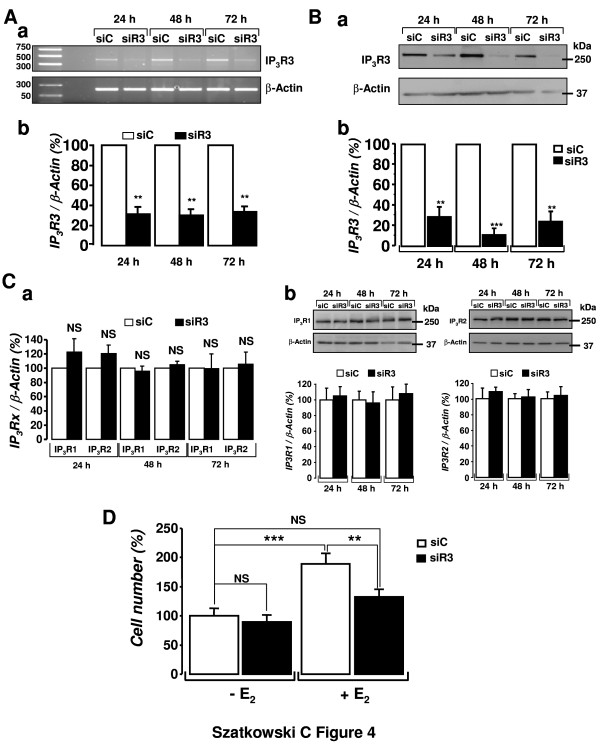
Silencing of IP3R3 by RNA interference limits the proliferative effect of E2. (A) Validation of the efficiency of the siRNAs used at the mRNA level (a, representative illustrations for 3 independent experiments). The IP3R3 mRNA level was lowered by about 70% (see text for details) at 24, 48 and 72 h post-transfection. (B) siR3 was responsible for a rapid and long-lasting diminution of the expression of IP3R3 at the protein level (a). Compared to control conditions, siR3 diminished the expression of IP3R3 at 24, 48 and 72 h (b). (C) Following IP3R3 silencing, the levels of IP3R1 and IP3R2 mRNA (a) and protein (b) were not significantly changed at 24, 48 and 72 h post-transfection. Representative blots for 3 to 4 independent western blotting experiments are shown. (D) MCF-7 cells were transfected with siC or siR3 and seeded for 18 h in 5-FCS and then starved for 6 h in 0-FCS. Cells were subsequently cultured in 0-FCS in the absence (-E2) of the presence (+E2) of E2 (10 nM) for 48 h. MCF-7 cell number was measured at 72 h post-transfection using the trypan-blue exclusion method. E2-induced increase in cell number was strongly diminished in siR3-transfected MCF-7 cells compared to siC-transfected cells (P < 0.01).